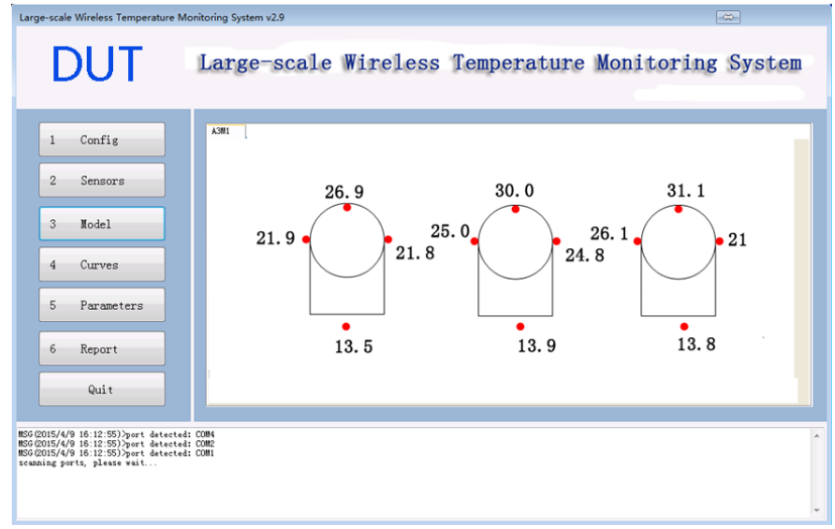
Figure 14. Model